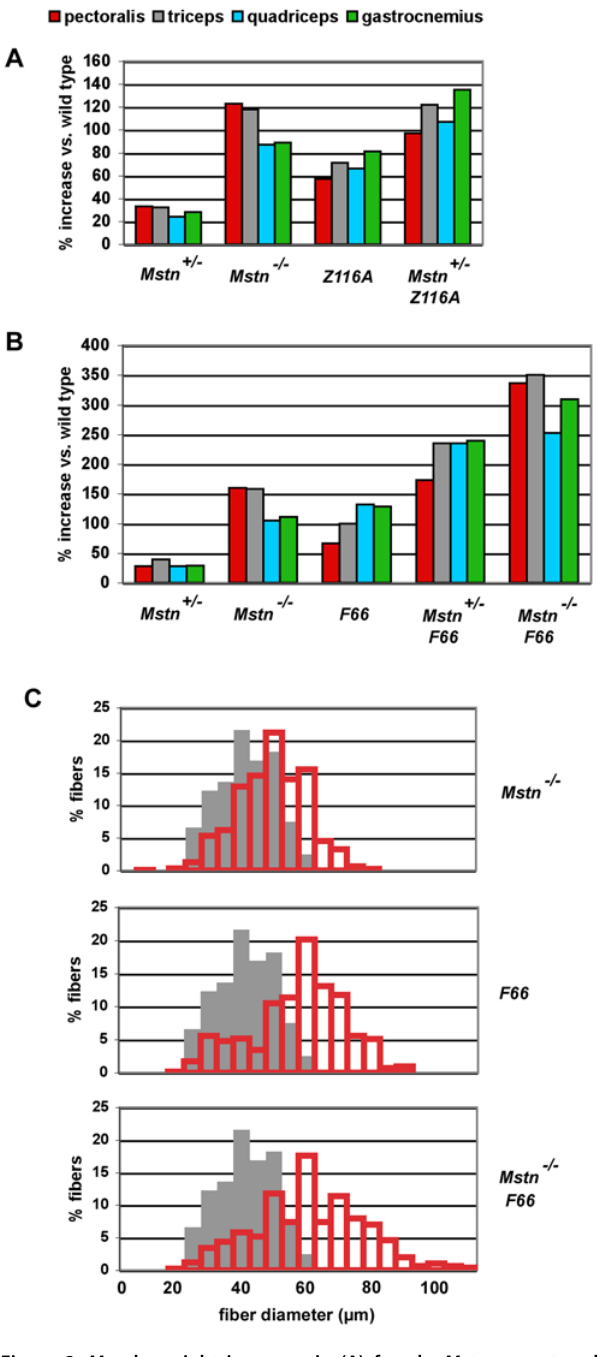
Figure 2. Muscle weight increases in (A) female Mstn mutant and Z116Atransgenic mice and (B) maleMstnmutant andF66transgenic mice. Numbers represent percent increases relative to wild type mice and were calculated from the data shown in Table 1. (C) Distribution of fiber diameters. Gray bars represent muscles from wild type mice, and red bars represent muscles from Mstn 2 / 2 , F66 , and F66/Mstn 2 / 2